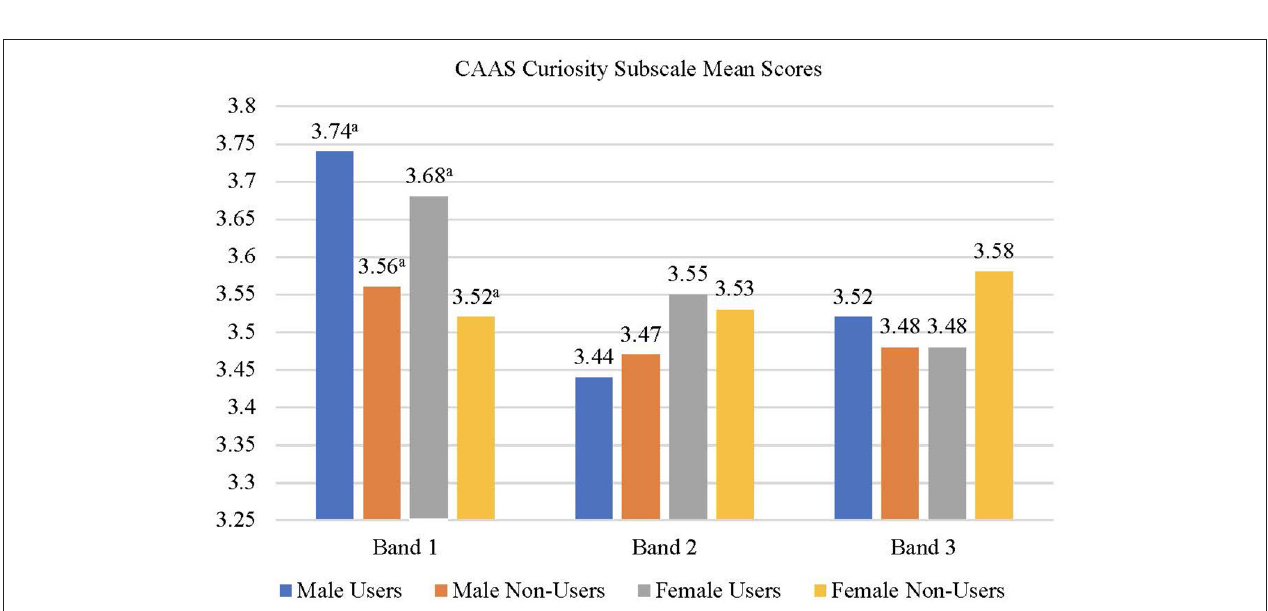
FIGURE 3 | User status × school banding interaction of the CAAS—curiosity subscale. N = 2,935 12th graders (1,549 females and 1,374 males, 12 unidentified; 844 users and 2,091 non-users). CAAS, Career Adaptability Scale. Scores ranged from 1 to 5 with higher scores indicating higher level of adaptability resources. a Users from band 1 schools had significantly higher scores than non-users from the same banding ( p < 0.01).